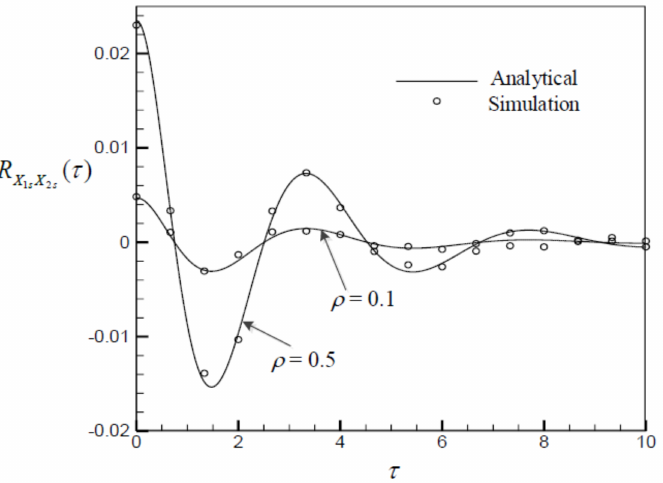
Figure 4. Cross − correlation functions of simulated excitations for σ 2 different values of ρ